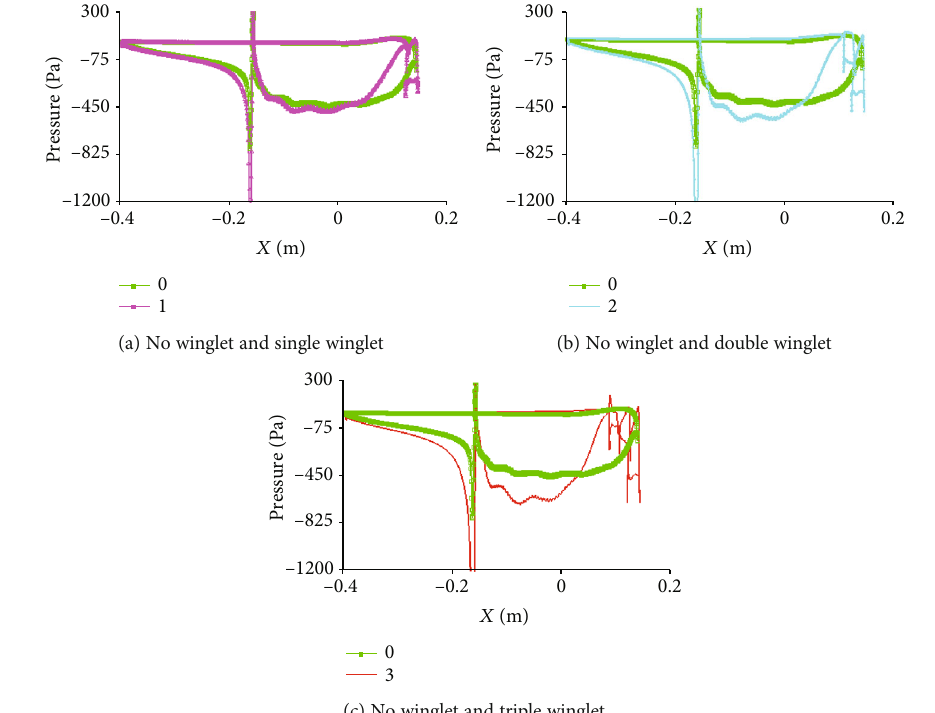
Figure 22: Static pressure distribution curves of leading edge winglets with di ff erent number of blades ( installation angle = 90 ° , v = 12 m/s, α = 0 ° ).